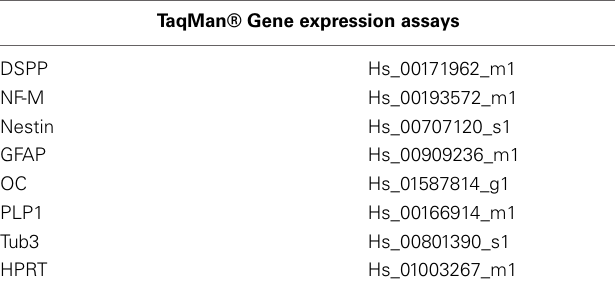
Table 1 | TaqMan gene expression assays ID of amplifications for real time